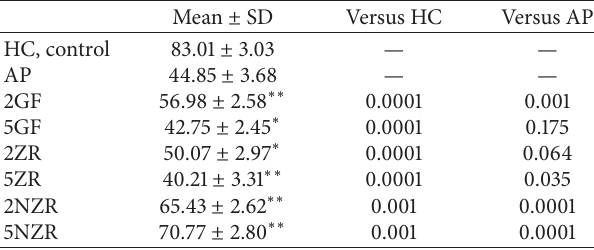
Table 2: Mean, standard deviation (SD), and 𝑃 values for different concentrations of glass fiber, zirconia, and nano-zirconia reinforce-